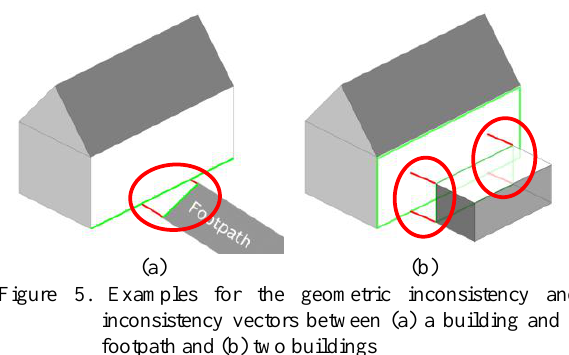
Figure 5. Examples for the geometric inconsistency and inconsistency vectors between (a) a building and a footpath and (b) two buildings